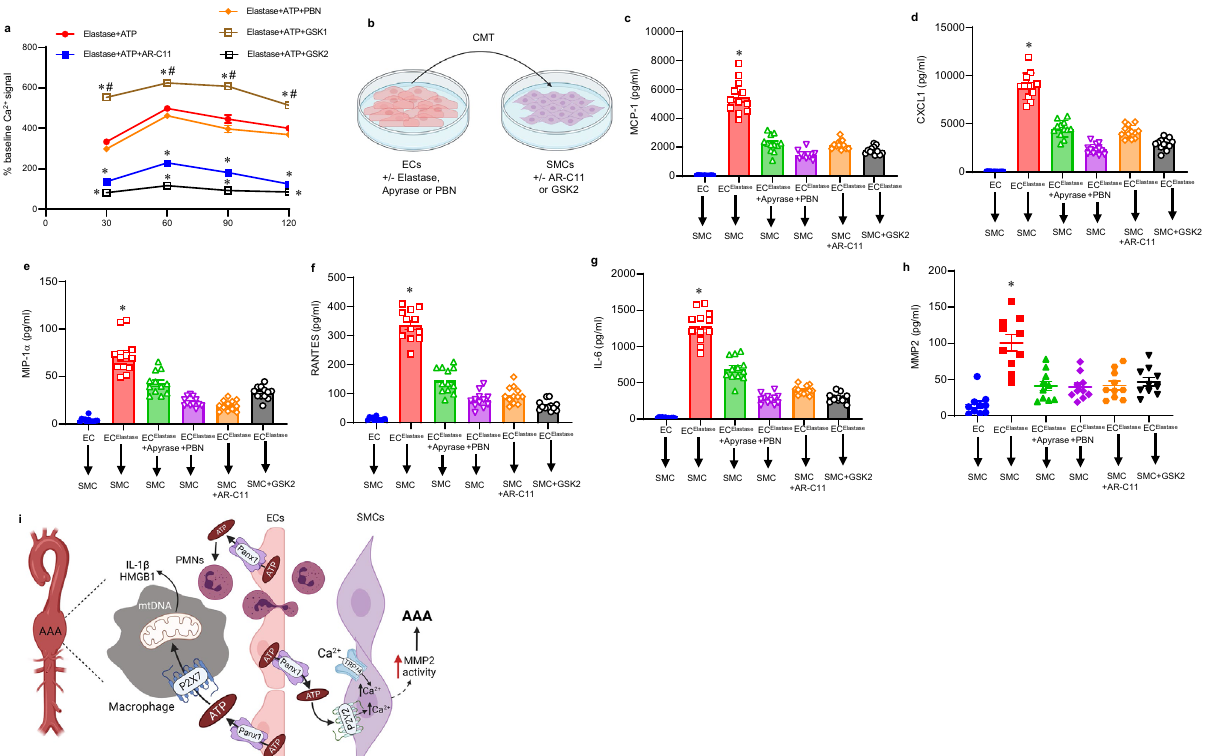
Fig. 6 Panx1-dependent ATP release from ECs results in SMC activation that is inhibited by P2Y2 and TRPV4 antagonism. a An increase in Ca 2 + -in fl ux was observed in elastase and recombinant ATP- (1 μ M) treated SMCs that was inhibited by P2Y2 (AR-C11) and TRPV4 antagonist (GSK2) blockade, but increased after TRPV4 agonism by GSK1 treatment. The Ca 2 + signal after treatment was expressed as % change intensity compared with baseline in untreated cells. * P < 0.0001 vs. elastase + ATP; # P < 0.0001 vs. elastase + ATP + GSK2; n = 12/group. b Schematic depicting conditioned media-transfer (CMT)-based experiments from elastase-treated ECs to SMCs with/without pretreatment with inhibitors. c – g CMT from elastase-treated ECs to primary SMCs induces a signi fi cant upregulation of MCP-1, CXCL1, MIP-1 α , RANTES, and IL-6 secretion, which was blocked by pretreatment of ECs with apyrase or PBN, as well as pretreatment of SMCs with P2Y2 or TRPV4 inhibitors, respectively. * P < 0.0001 vs. all other groups; n = 12/group. h Primary SMCs were treated with CMT from elastase-treated ECs and MMP2 activity secretion was analyzed in cell culture supernatants after 24 h. A multifold increase in MMP2 activity was observed in SMCs after CMT from elastase-treated ECs compared with controls, and was signi fi cantly attenuated by pretreatment of ECs with apyrase or PBN, as well as pretreatment of SMCs with P2Y2 or TRPV4 inhibitors, respectively. * P < 0.0001 vs. other groups; n = 8/group. i Schematic representation of signaling events mediated by Panx1 signaling during the pathogenesis of AAA. ATP release from Panx1 channels in aortic ECs modulates macrophage activation via P2X7 receptors, and stimulates mtDNA release, leading to IL-1 β and HMGB1 secretion thereby causing aortic in fl ammation. Also, Panx1-mediated ATP release from ECs activates P2Y2 receptors and TRPV4 channels on SMCs to stimulate pro-in fl ammatory cytokine secretion and destabilization of intracellular Ca 2 + homeostasis that facilitates increased MMP2 activity resulting in aortic remodeling. Panx1/ATP signaling also contributes to leukocyte traf fi cking in the aortic wall, as observed by transendothelial migration of neutrophils. HMGB1, high-mobility-group box1; PMNs, neutrophils; ECs, endothelial cells; SMCs, smooth-muscle cells; mtDNA, mitochondrial DNA. Comparative data are represented as mean values ± SEM and statistical analyses were done by one-way